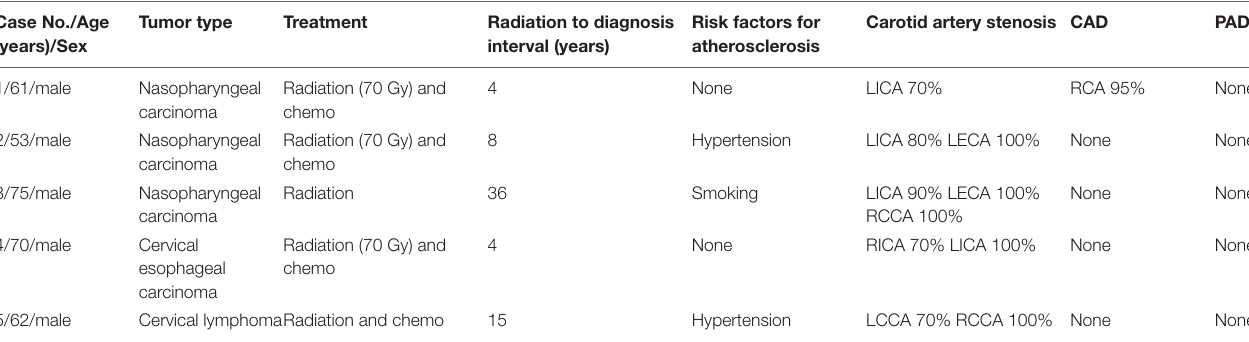
TABLE 1 | Demographic, clinical, and radiological features of five patients with a history of cervical radiotherapy. Case No./Age